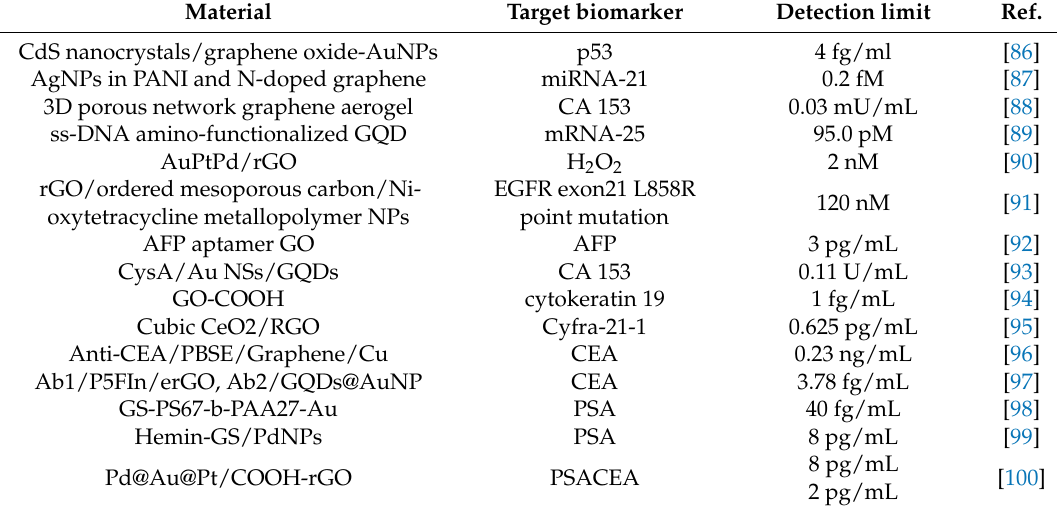
Table 1. Summary of innovative electrochemical biosensors for cancer biomarkers detection. Material Target biomarker Detection limit Ref.